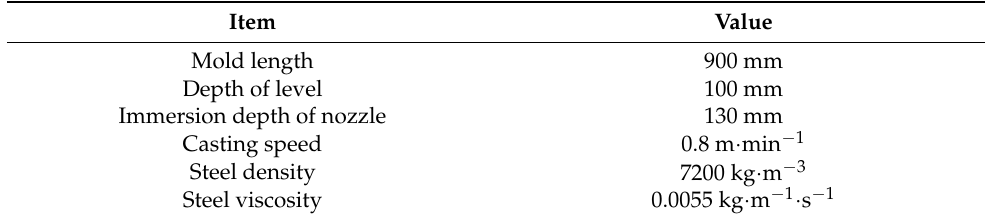
Table 2. Calculated